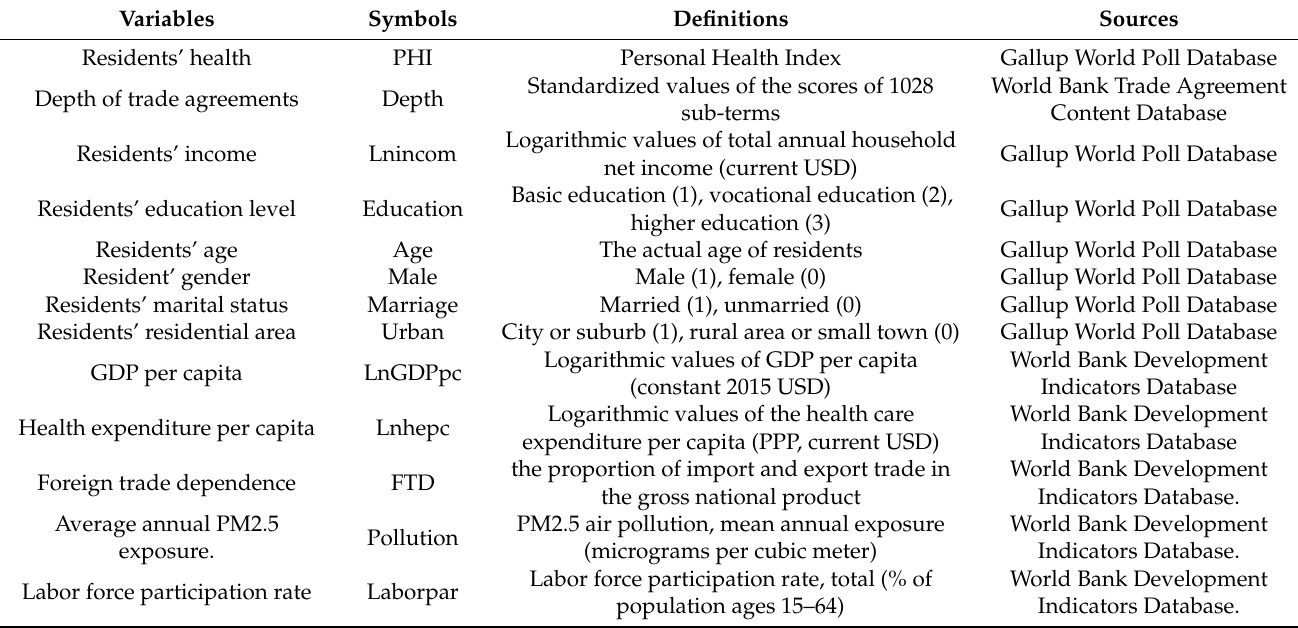
Table 2. Variables definition and sources.